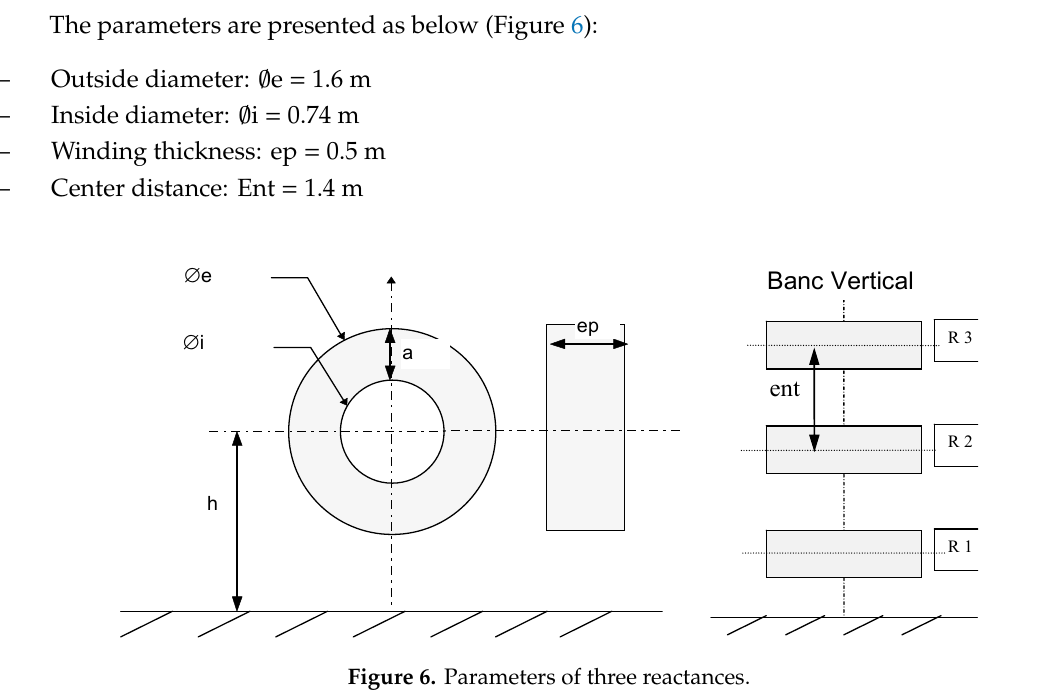
Figure 5. Three phase reactance in the power station “Folies”.